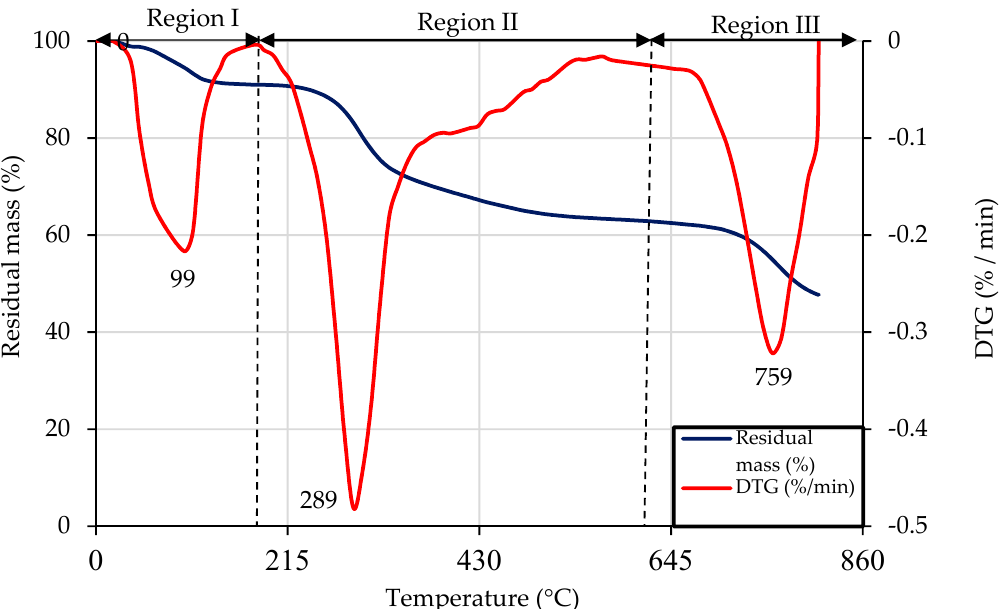
Figure 1. Thermograms (TGs) and its first derivative (DTG) of the used raw poultry manure (RPM dose = 16.7 mg; heating gradient = 10 °C min − 1 ).